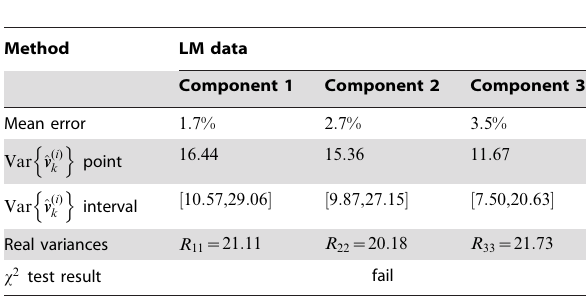
Table 6. x 2 test results for the estimation of 18 parameters in the repressilator model